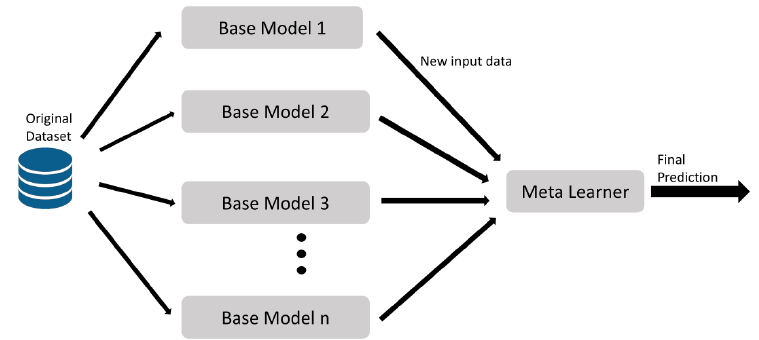
Figure 8. Stacking learning